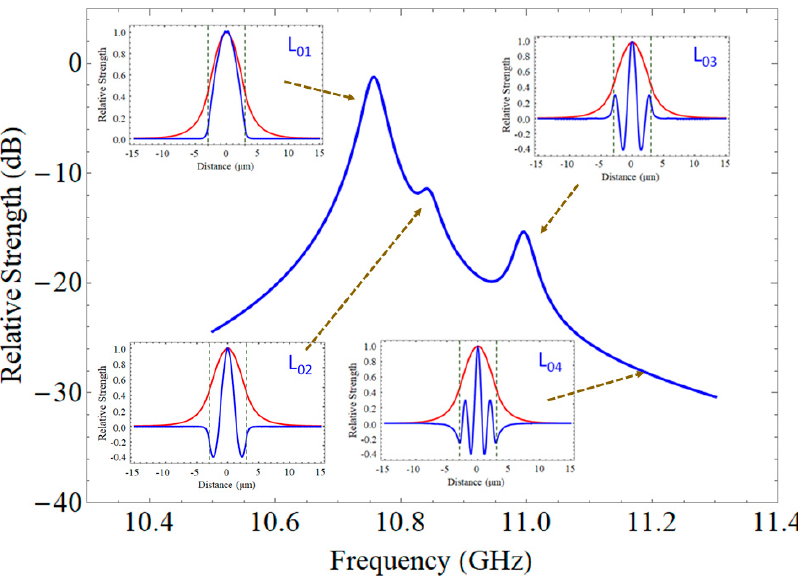
Figure 3. Simulated Brillouin gain spectrum (BGS) calculated (1534 nm) from the profiles in Figure 2. The positions of the longitudinal mode interactions are also shown. The insets plot the LP 01 optical mode intensity (red) and the acoustic displacement u z ( r ) (blue). Vertical dashed lines in the insets delineate the core